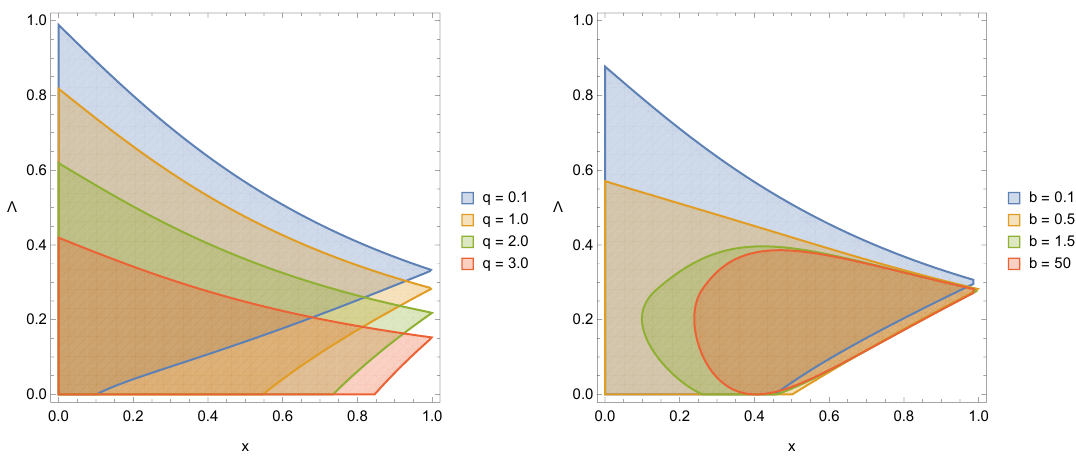
Figure 2 . Regions of positivity for the surface tension (cid:21) as a function of x and (cid:3) with (cid:12)xed p cavity radius r c = 3. Shaded regions indicate positivity, where (cid:21) should be regarded as a surface pressure. Left : varying charge with b = 0 : 1. Right : varying b with q = 0 : 7.